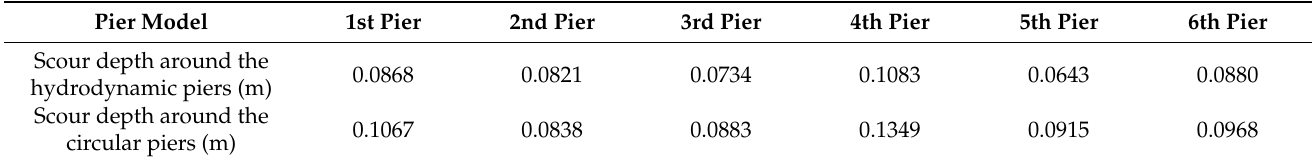
Figure 8. Maximum scour depth in the group piers. Table 4. Comparison of the maximum scour depths.